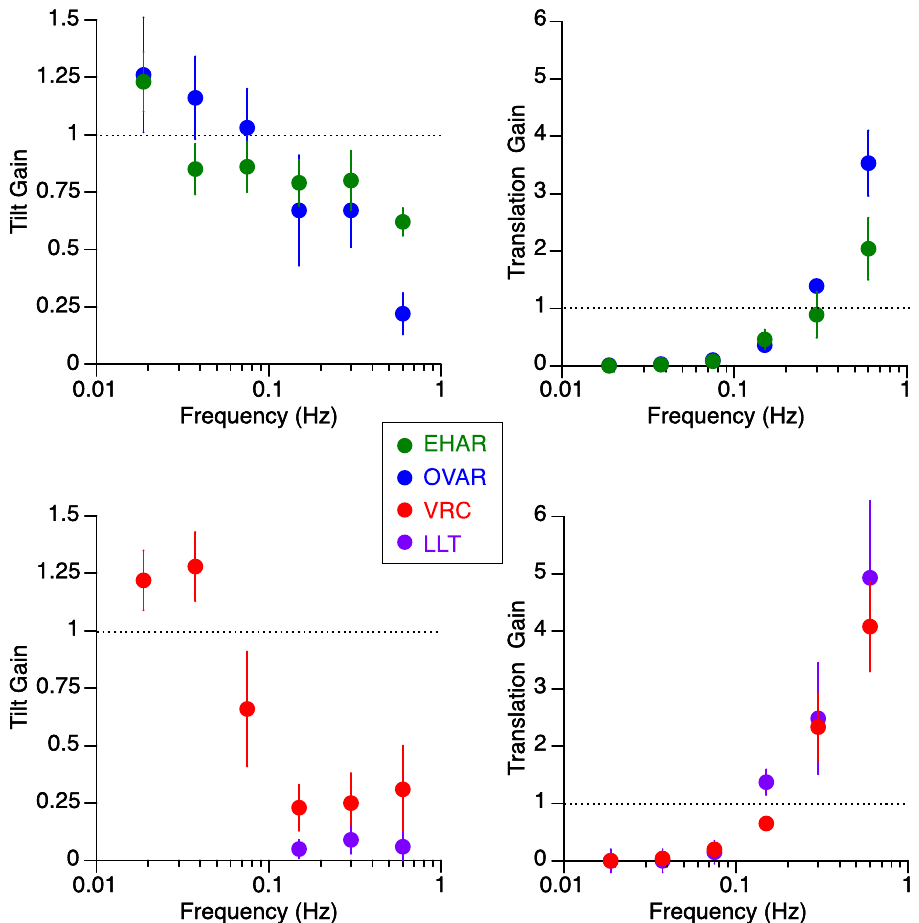
Figure 3. Mean ± standard error of tilt gain and translation gain (from 12 subjects) as a function of frequency during each of the 4 motion paradigms generating an equivalent tilt of 10°. Tilt gain is the ratio of perceived tilt angle and equivalent (i.e., the actual or the resultant tilt from linear acceleration and gravitation acceleration stimuli) tilt angle. Translation gain is the ratio of perceived translation displacement and the equivalent linear